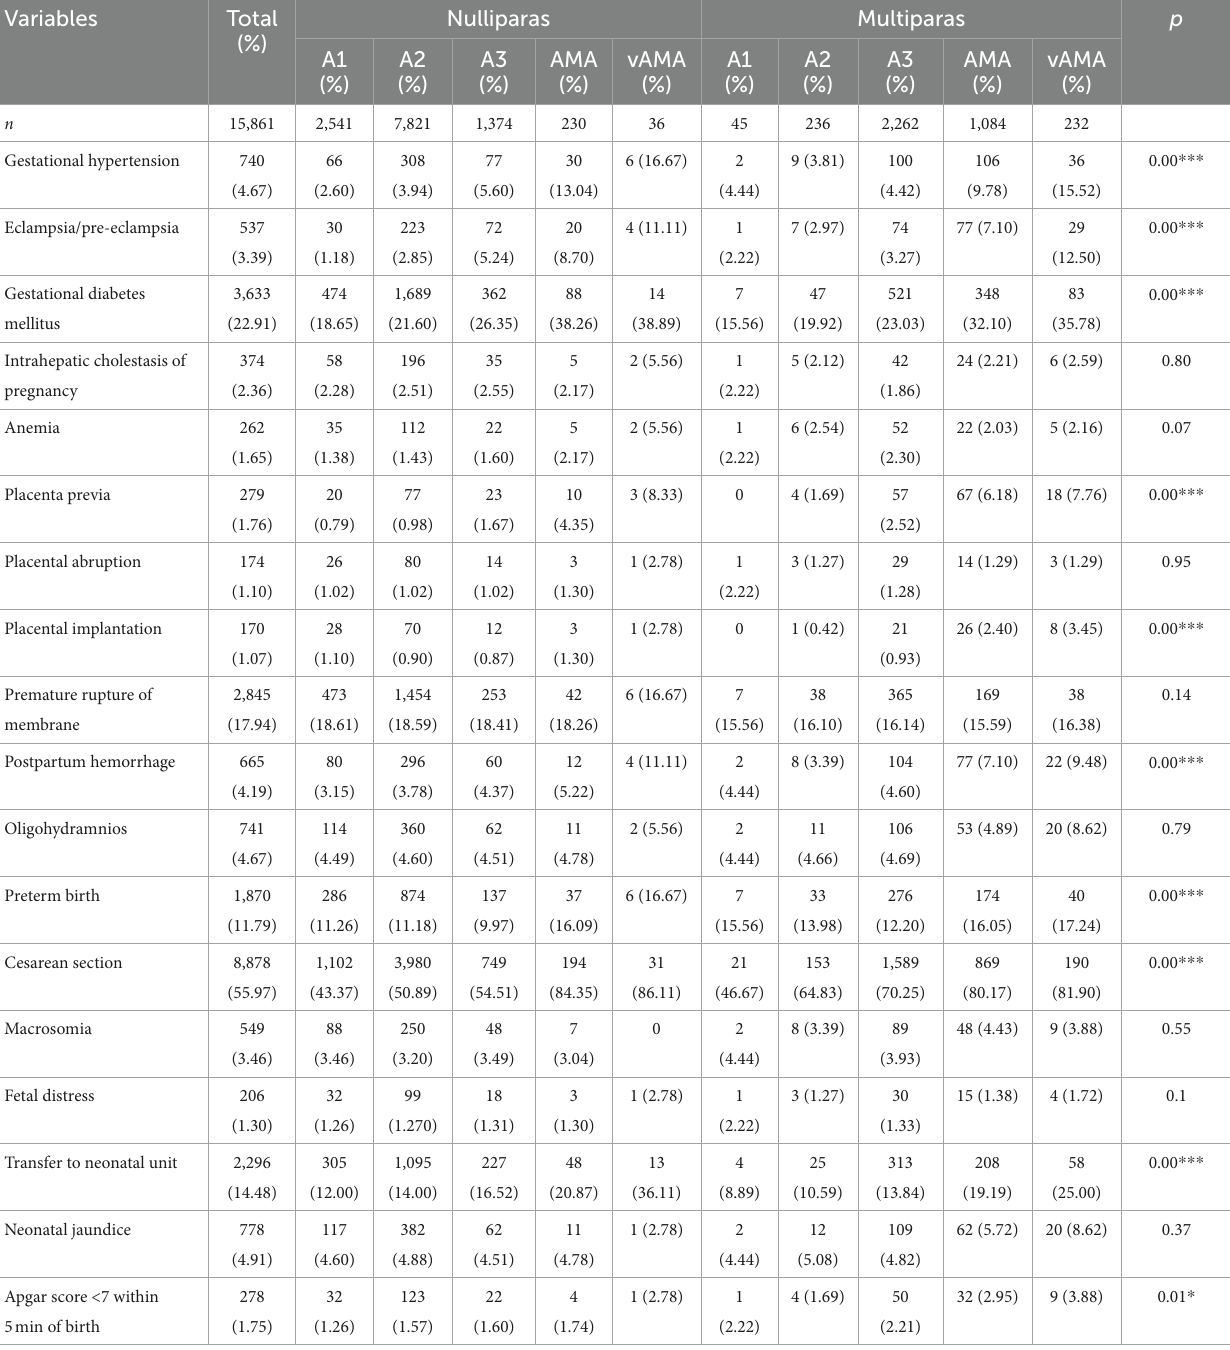
TABLE 4 Incidences of adverse pregnancy outcomes and neonatal outcomes for the mixture group with different ages and parities.